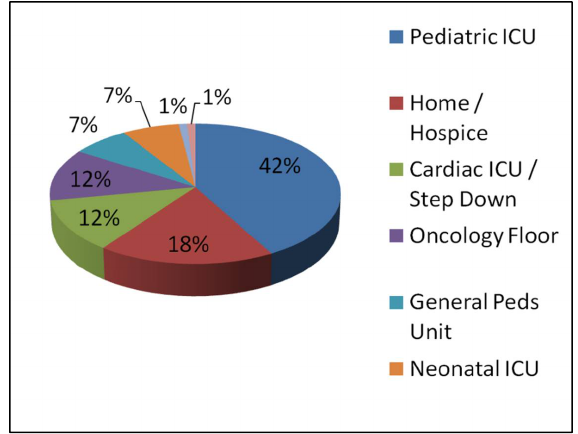
Figure 2. Location of death for patients with a DNR order in place.